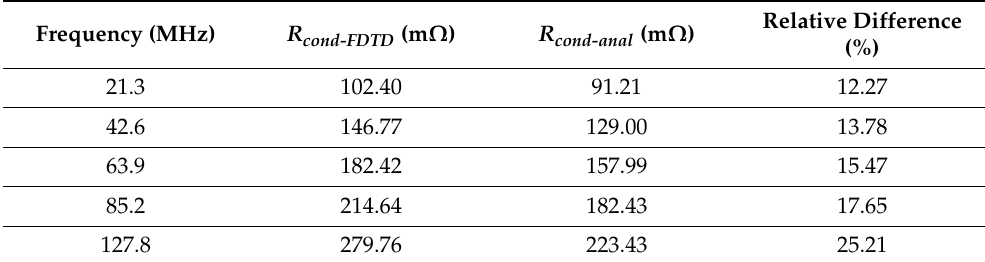
Table 6. Coil conductor resistance estimation for different frequencies ( n = 2-segment loop). FDTD and analytical calculation results.